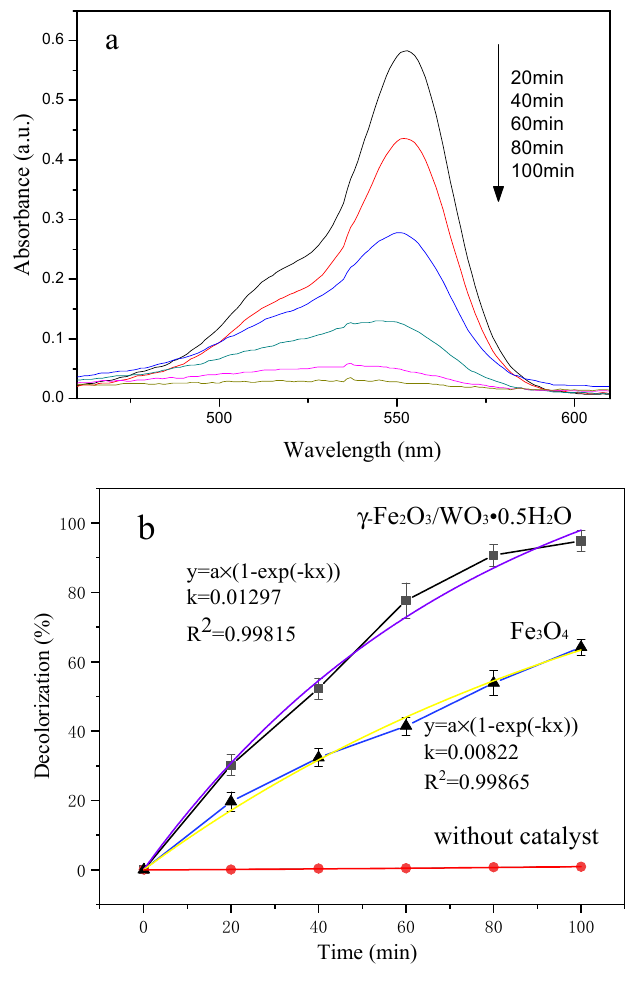
Figure 6. ( a ) Absorption spectrum of RhB solution in the presence of γ -Fe 2 O 3 /WO 3 ·0.5H 2 O under UV-Visible light; ( b ) degrading efficiency at different times with various or without catalysts under UV-Visible light. The purple curve and yellow curve are the pseudo-first-order models’ fitting